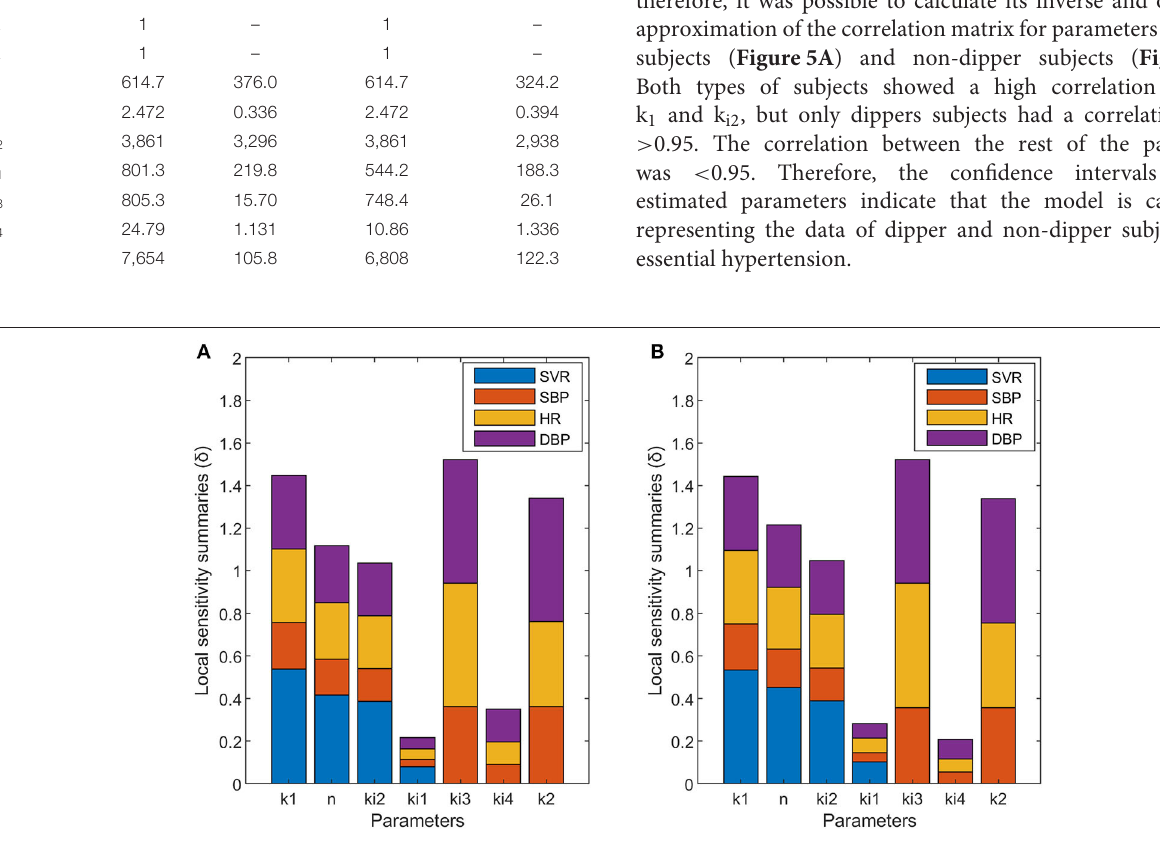
Frontiers in Physiology |